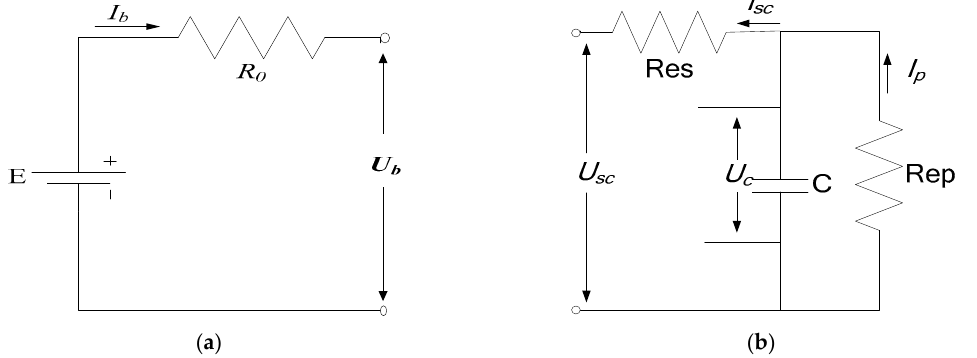
Figure 2. Simplified circuit models of battery and super capacitor (SC). ( a ) Rint model of the battery; ( b ) Transmission line model of